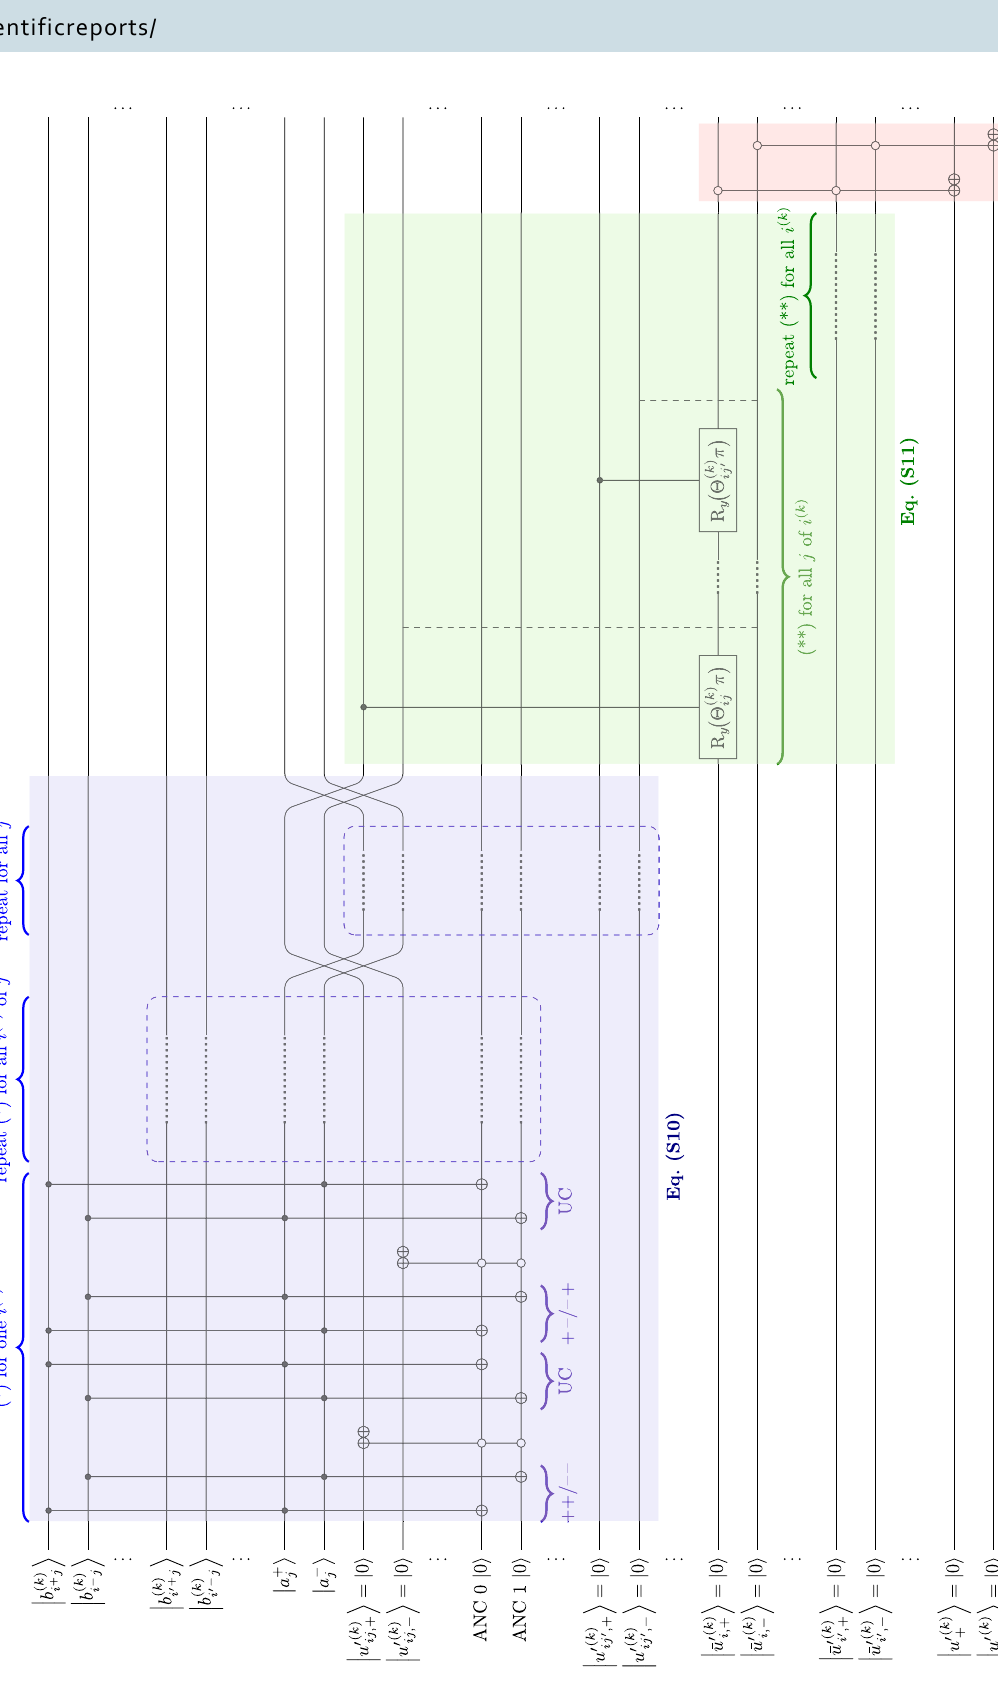
Figure 8. Extract of quantum algorithm for the utility evaluation process. UC: uncomputation. For simplicity, � ( k